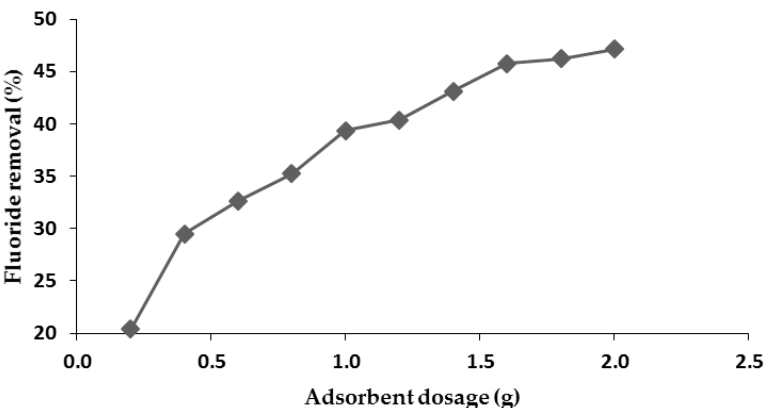
Figure 6. Optimisation of mass (70 min, 25 °C and 200 rpm).